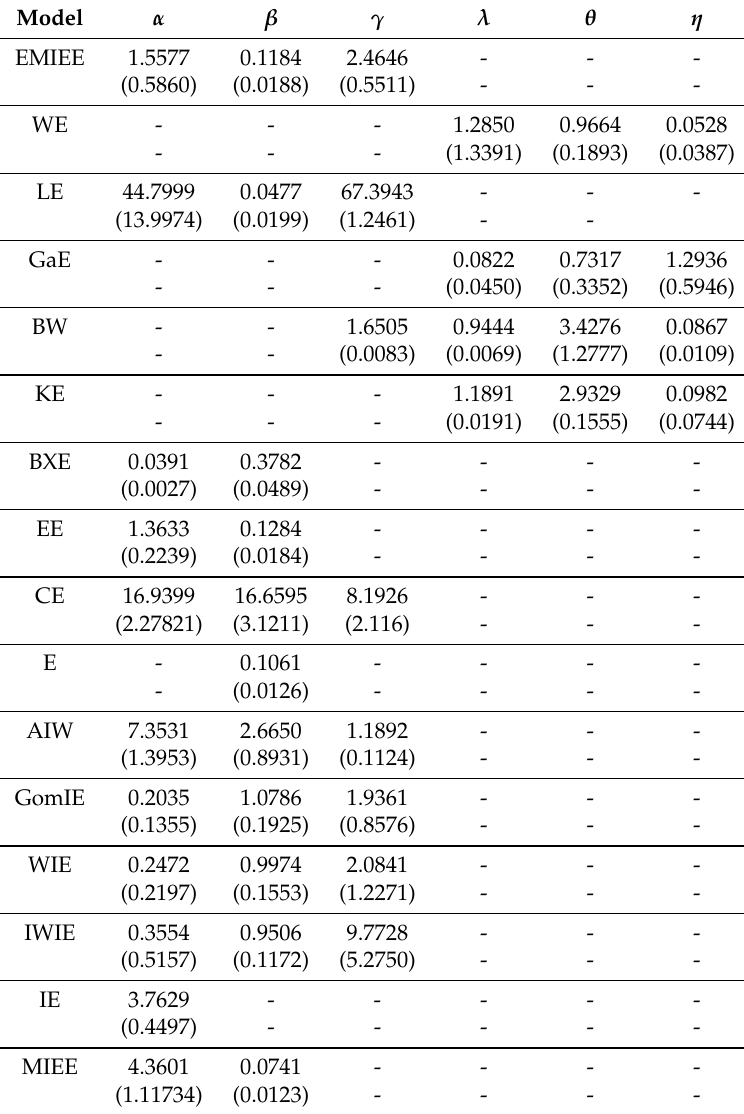
Table 7. MLEs and standard errors (SEs) (under parentheses) of the model parameters for the COVID-19 dataset: Weibull-exponential (WE) model, the Lomax-exponential (LE) model, the gamma-exponentiated exponential (GaE) model, the beta Weibull (BW) model, the Kumaraswamy exponential (KE) model, the Burr X-exponential (BXE) model, the exponentiated exponential (EE) model, the CStransformation of exponential (CE) model, the standard exponential (E) model, the alpha-power inverse Weibull (AIW) model, the Gompertz inverse exponential (GomIE) model, the Weibull-inverse exponential (WIE) model, the inverse Weibull-inverse exponential (IWIE) model, the inverse exponential (IE)